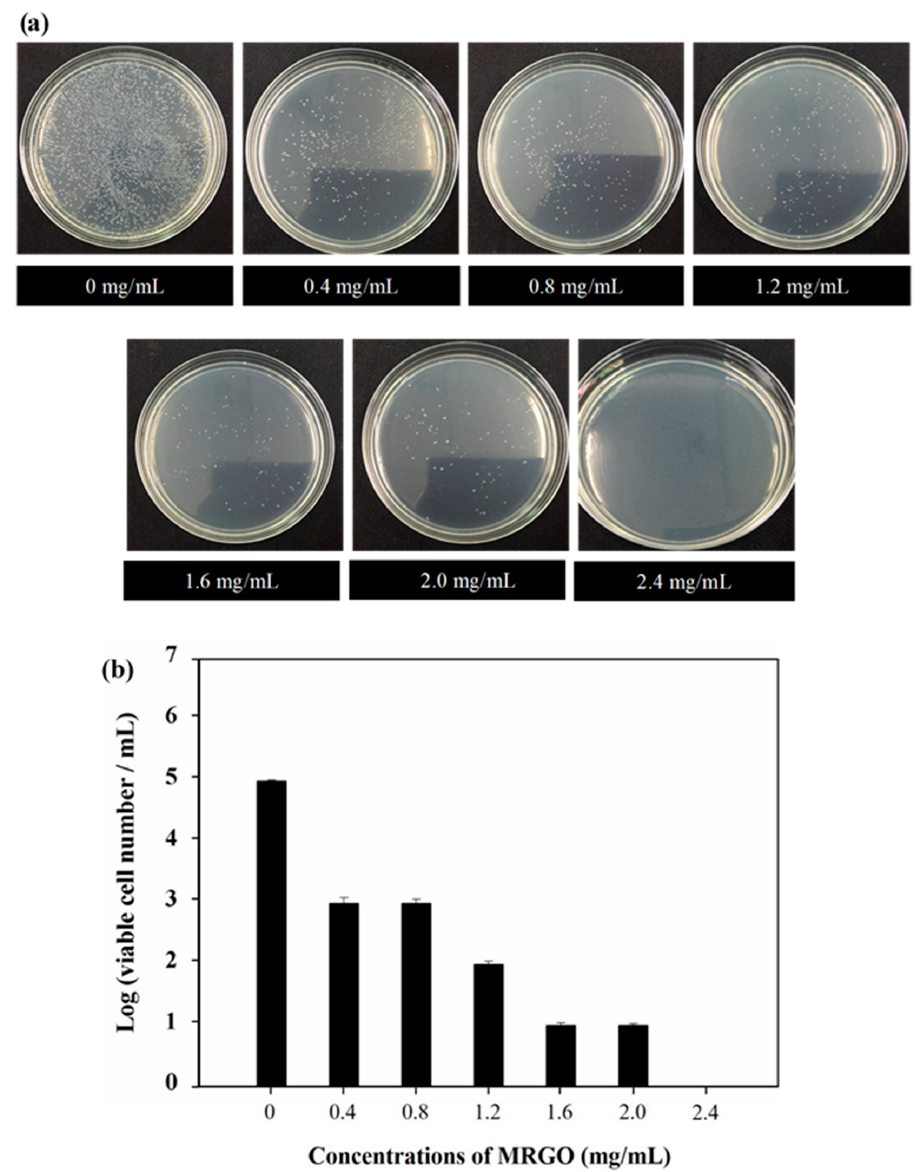
Figure 5. ( a ) Capturing activity toward the supernatant of S. aureus (105 CFU / mL) solution with various concentrations of MRGO; ( b ) survival S. aureus numbers with various concentrations of MRGO.